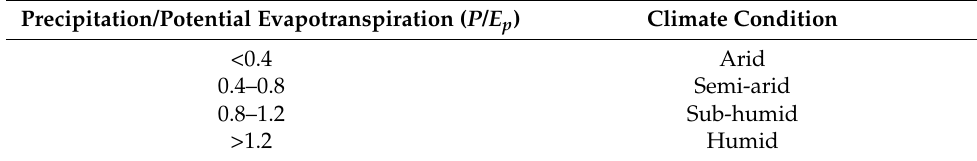
Table 11. The ratio between the P and E p and relevant climate conditions